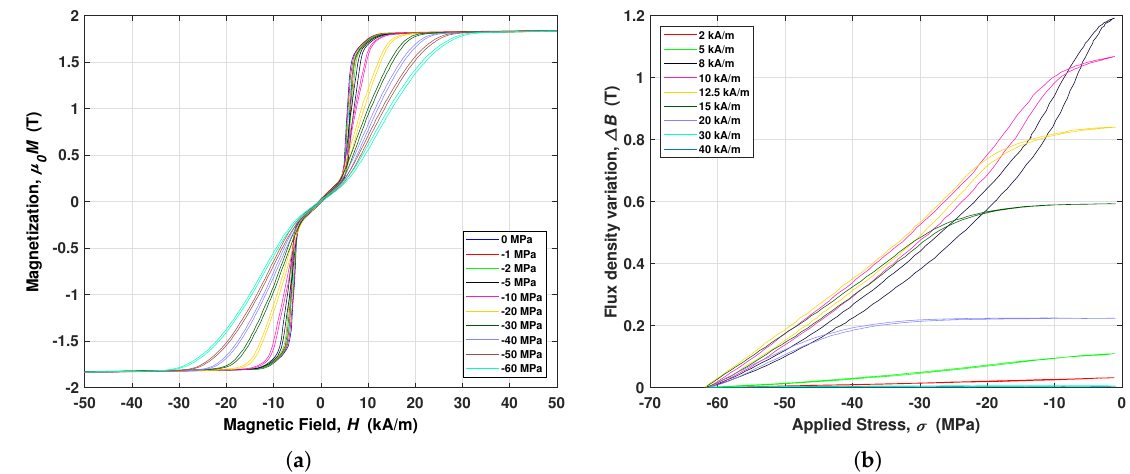
Figure 2. Magneto-mechanical characteristics of SA Galfenol. ( a ) Magnetic characteristics at different compressive applied stress. ( b ) Flux density variation by applying cyclic compressive stress for different magnetic bias conditions (harvesting